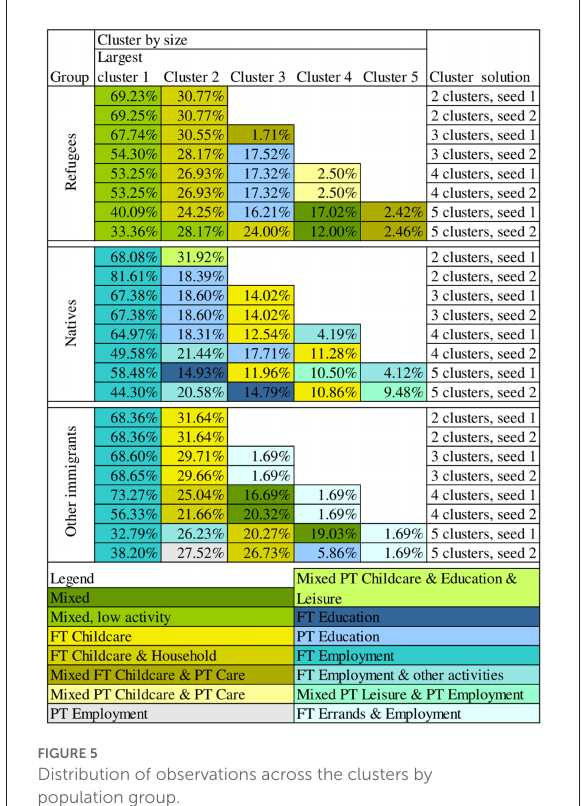
FIGURE5 Distribution of observations across the clusters by population